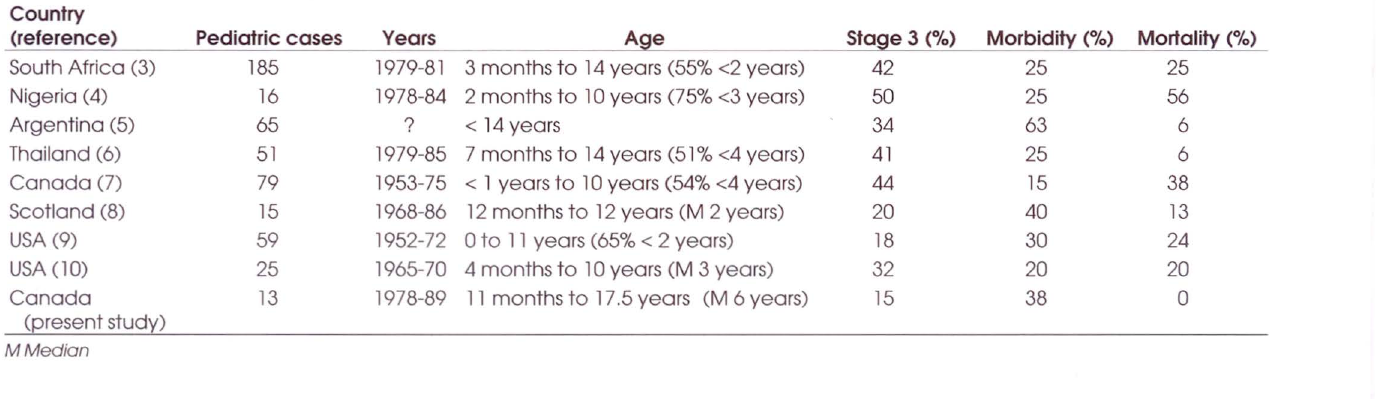
Summary of morbidity and mortality of tuberculous meningitis observed in previous